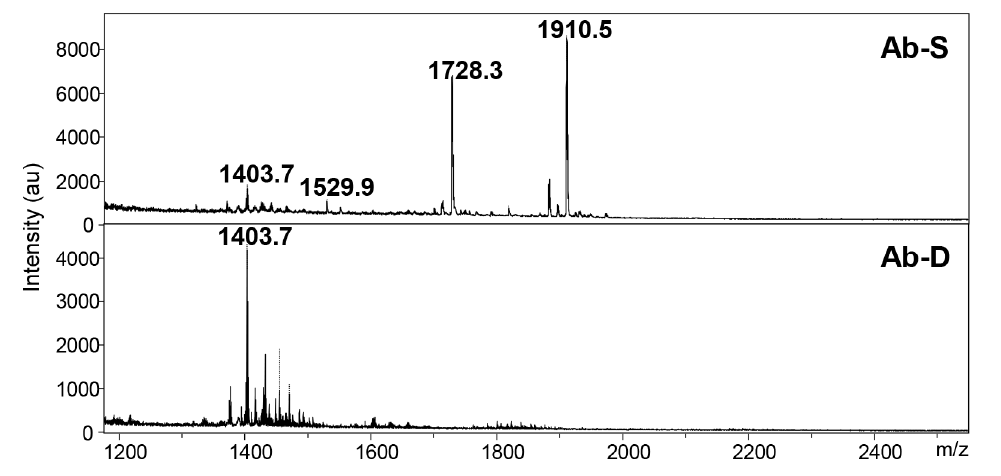
Figure 3. The mass spectra for lipid A in A. baumannii populations. Two A. baumannii populations, susceptible to colistin (Ab-S) and colistin-dependent (Ab-D) were grown on MHA plates with colistin Etest strip. Cells were collected, lipid A was extracted, and samples were subjected to MALDI-TOF MS analysis. In Ab-S, the mass spectrum of lipid A was dominated by peaks at m / z values of 1910.5, 1728.3 and 1529.9 ( upper panel ). The major peaks 1910.5 and 1728.3 were missing in the Ab-D mass spectrum ( lower panel ). Table 1. Whole genome sequencing (WGS) of Ab-S and Ab-D subpopulations of A. baumannii. Subpopulation Ab-S Ab-D Genome length 4,111,821 bp 4,125,623 bp Reference *